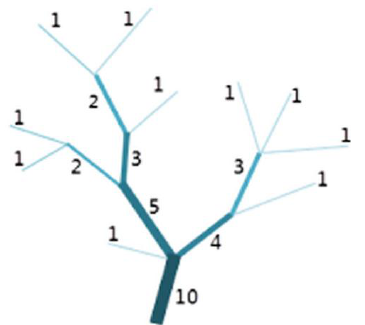
Figure 3. The ordering of streams based on the Shreve